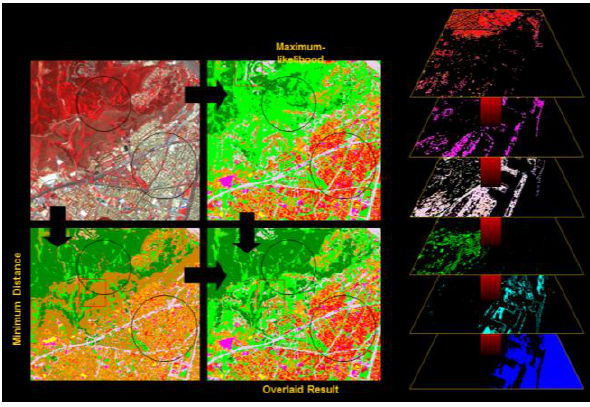
Figure 2.Overlay classifications